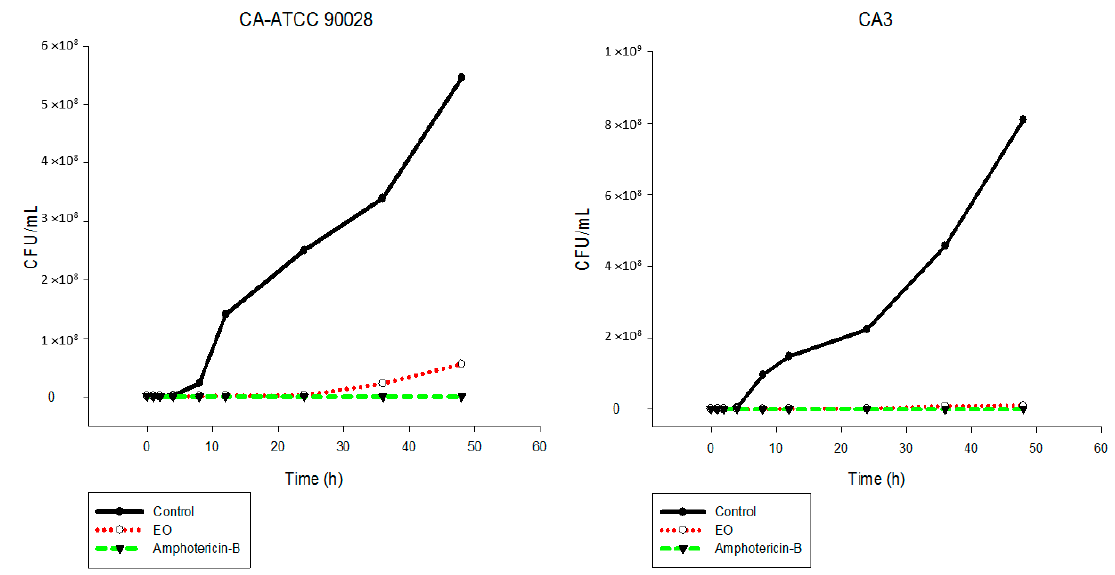
Figure 2. Time-kill curves of C. albicans ATCC 90028 and CA3 following exposure to the essential oil of C. nardus and amphotericin-B. Control represents the untreated Candida cells.